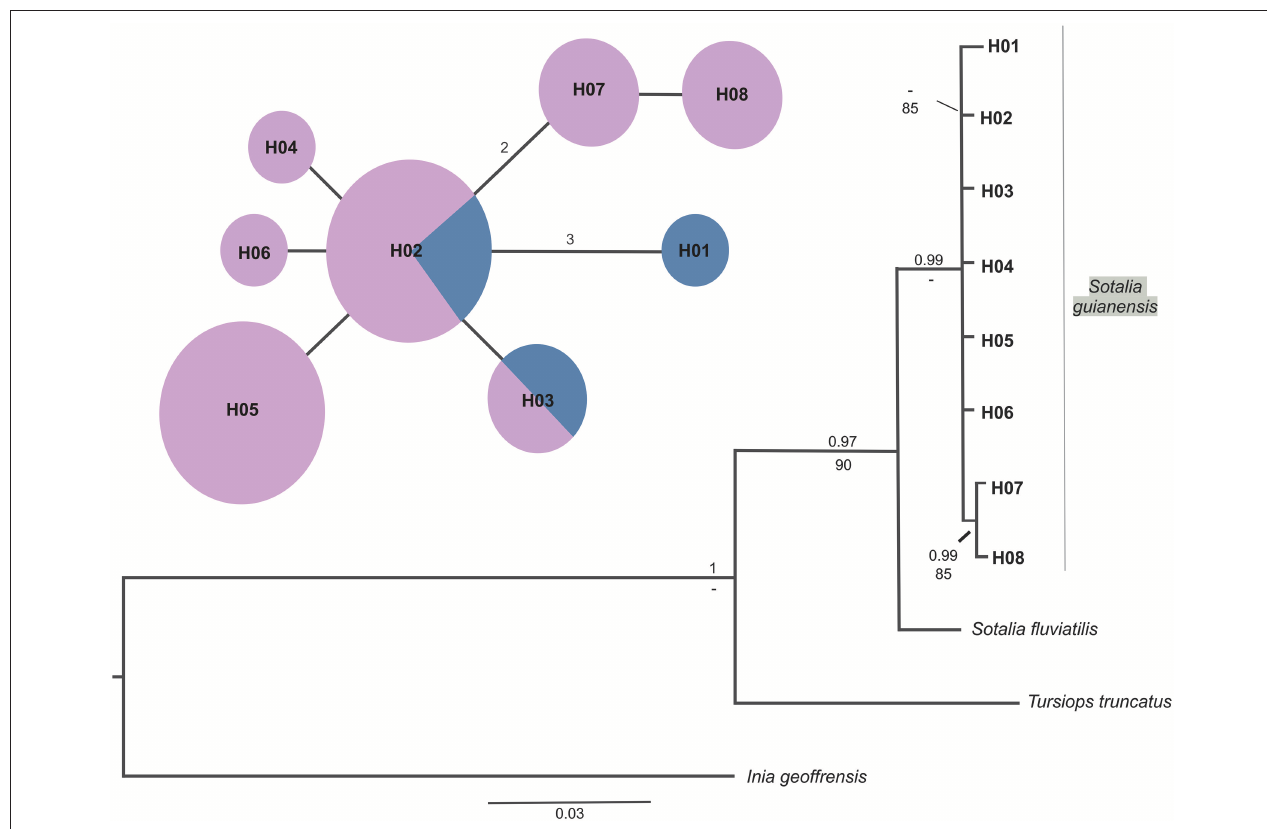
FIGURE 4 | (A) MJ analysis of Sotalia guianensis carried out with variable sites. Values above branches indicate the number of mutations between two haplotypes. Branches without values showed only one mutation. Blue circles or slices, represents samples purchased in this work. Pink circles or slices, represents GB sequences. (B) Phylogenetic reconstruction of Sotalia guianensis carried out with TrN + I model, and Bayesian analysis (BA), maximum likelihood (ML) with bootstrap based on 1,000 replicates. Numbers above branches are posterior probabilities, and below are bootstrap values. Low value support ( > 70%) are not shown. Haplotypes are described in Table 2